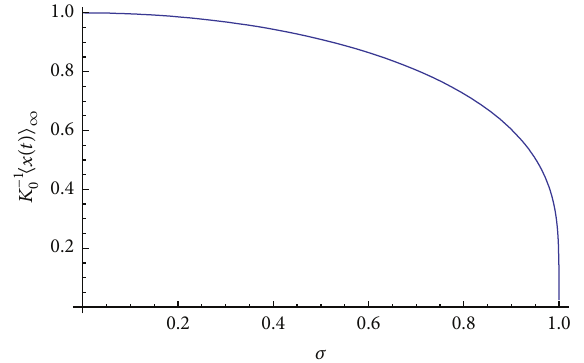
Figure 4: The plot of 𝐾 −1 0 ⟨𝑥(𝑡)⟩ ∞ as function of the noise intensity 𝜎 . The values of the parameters are 𝛾 = 0.8 , 𝜇 = 0.5 , and 𝑟 = 1 . In this case, 𝛾𝜇 = 0.4 < 2𝑟 and, for 𝜎 ∼ 1 , the number of individuals decreases with an infinite slope.